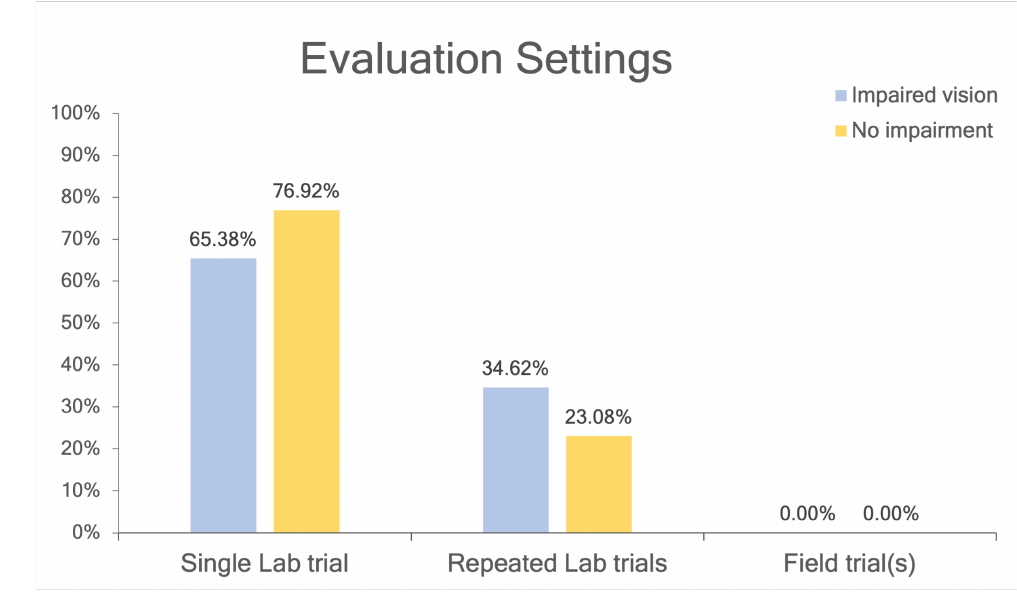
Figure 7. Evaluation environment settings for prototypes aimed at VIBPs and non-impaired persons.